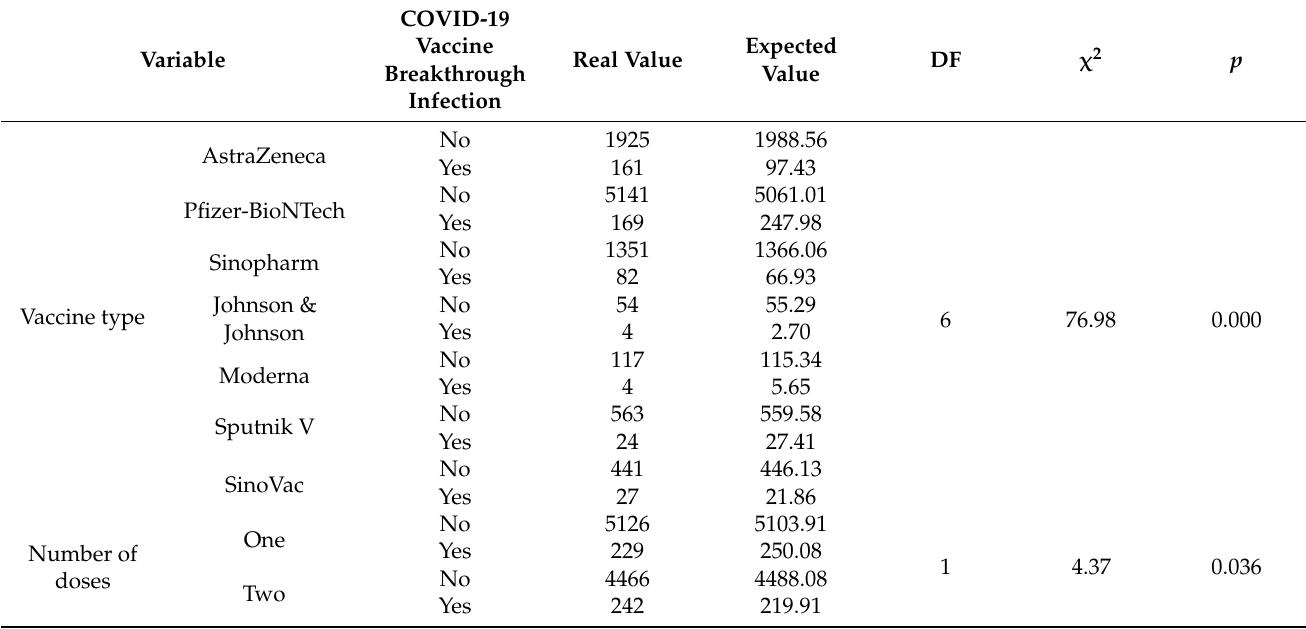
Table 5. The χ 2 testing of statistical associations of both vaccine type and number of doses with experiencing COVID-19 vaccine breakthrough